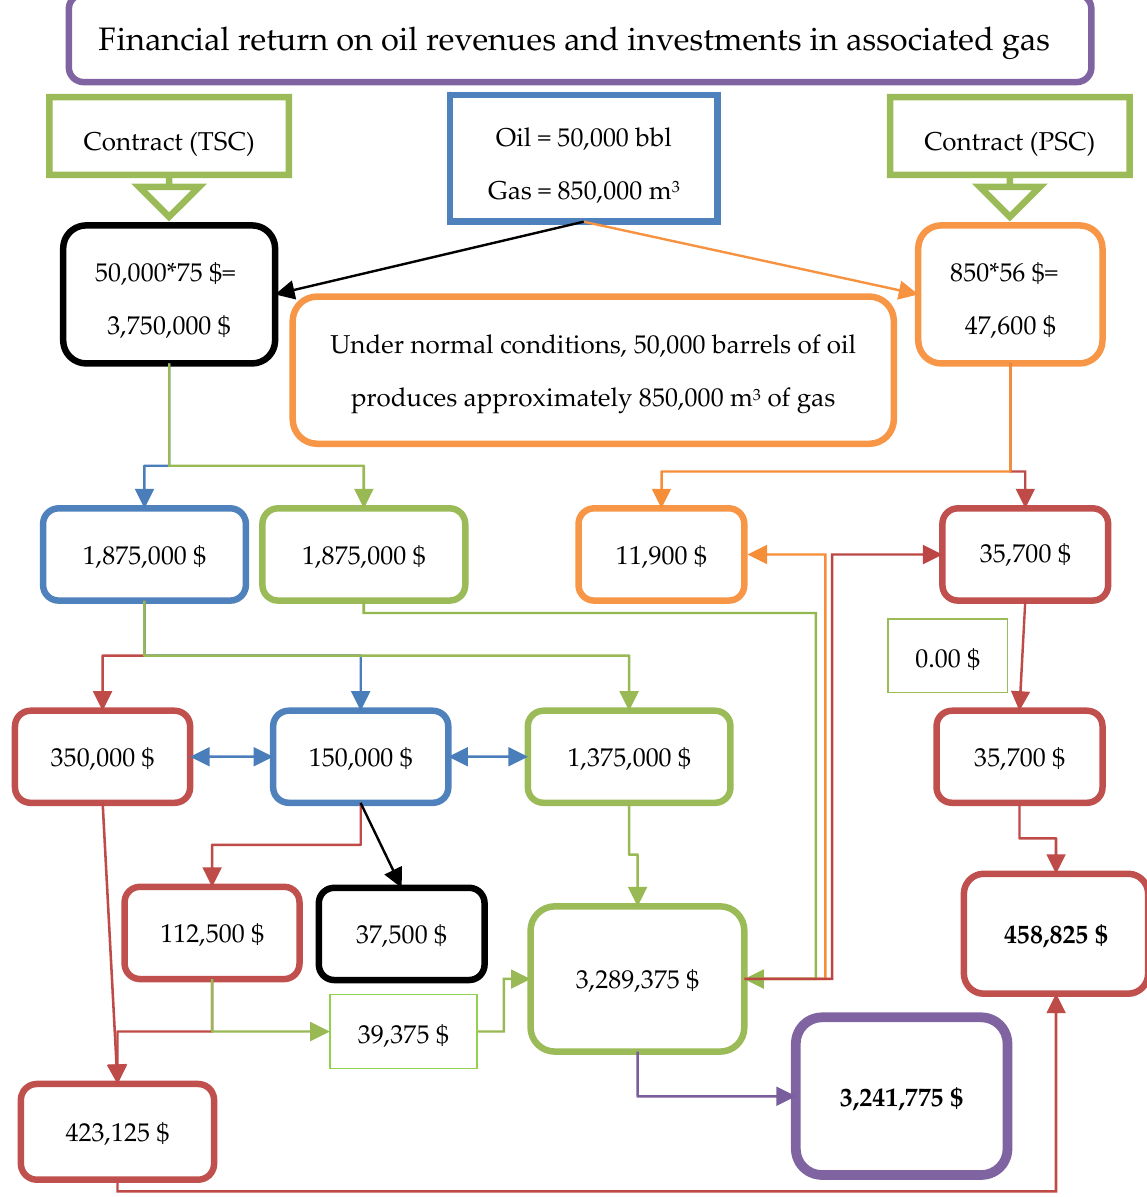
Figure 4. Financial return when investing in associated gas.